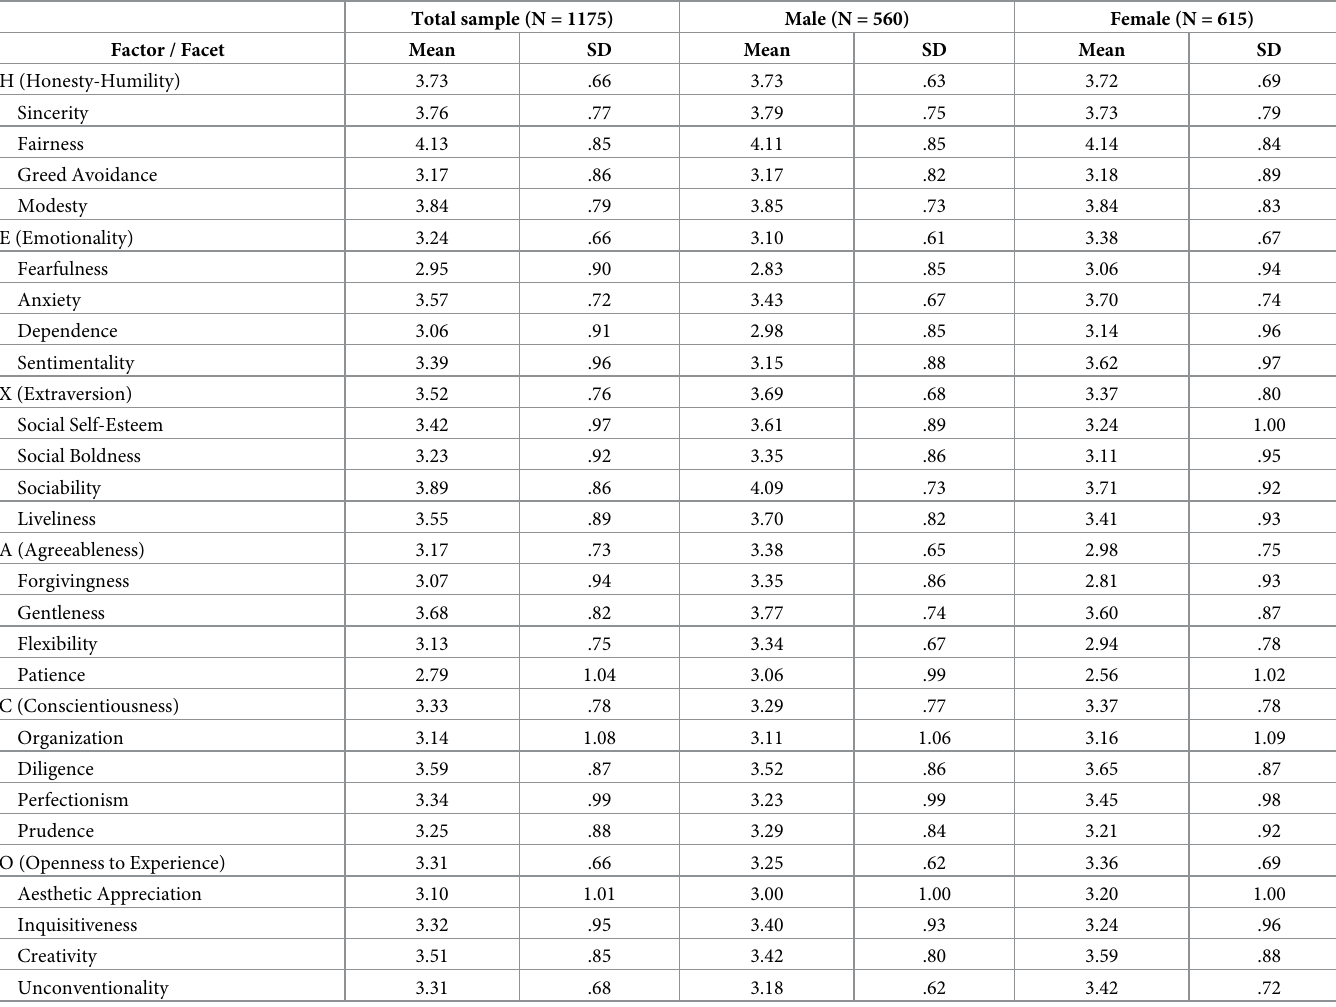
Table 7. Descriptive statistics (mean and SD) for the entire sample (N = 1175), for males (N = 560) and females (N =